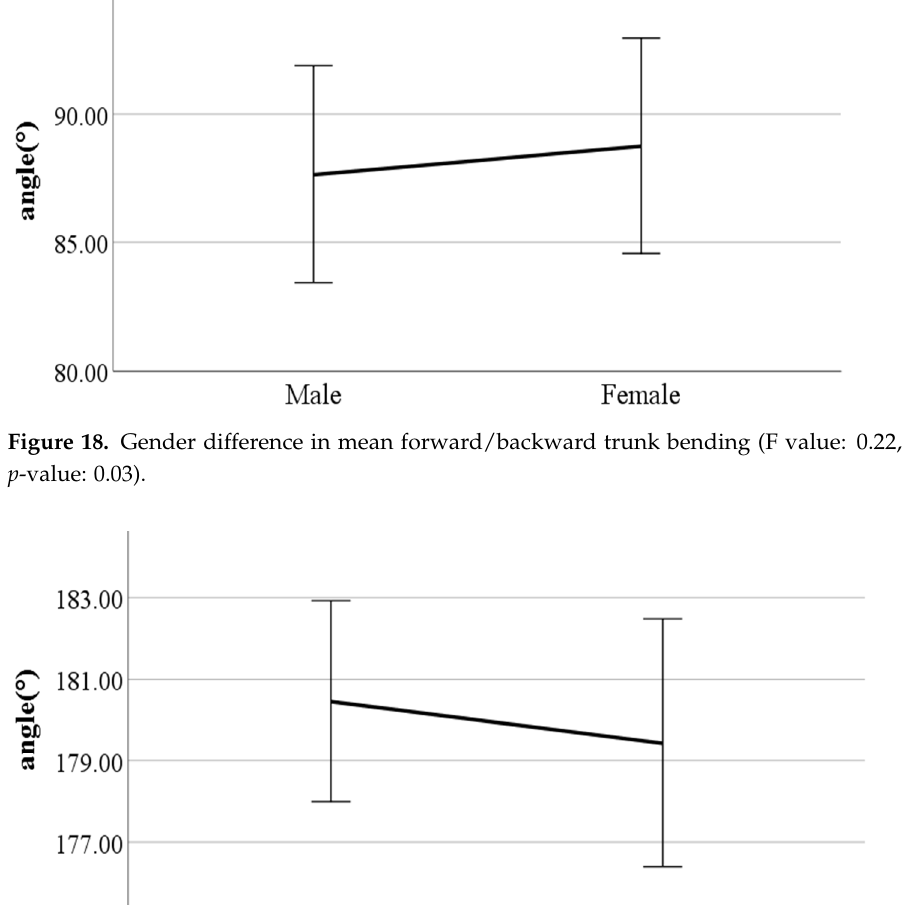
Figure 17. Gender difference in forward, backward trunk bending at heel-strike (F value: 0.19, DF: 289, p -value: 0.00).